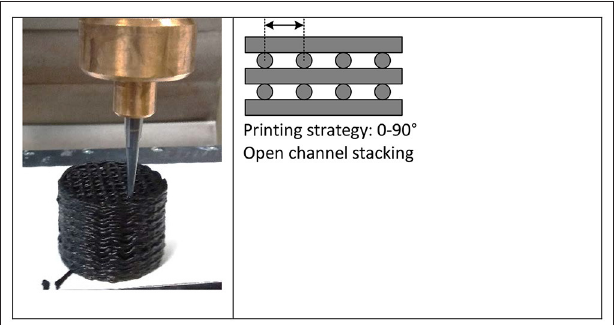
FIGURE 1 | 3D printing of CO 2 adsorbent structures.